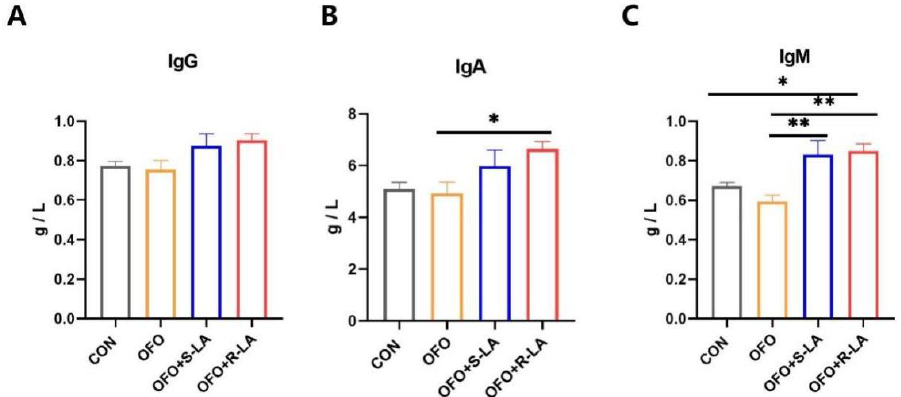
Figure 2. Effect of different treatments on immunoglobulin of laying hens. ( A ) Immunoglobulin G (IgG); ( B ) immunoglobulin A (IgA); ( C ) immunoglobulin M (IgM). * Indicates minimum significant differences ( p < 0.05), and ** indicates highly significant differences ( p < 0.01).